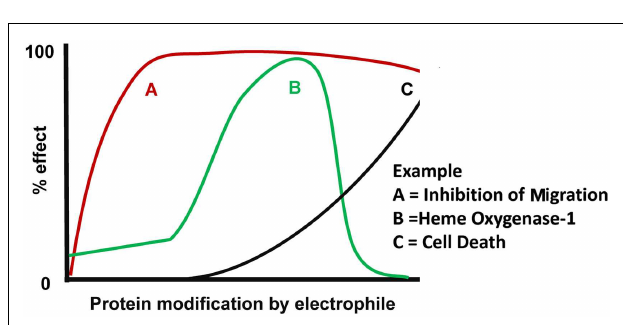
FIGURE 4 | Model of coordinated cellular effects in response to electrophilic protein modification. The overall cellular effects of an electrophile are dependent on the susceptibility of different target proteins to be modified by that electrophile.With low levels of electrophile exposure, post-translational modification of the most sensitive target will elicit a cellular response “A.”With moderate electrophile exposure, modification of (an) additional target(s) will result in cellular response “B.” Since response A is still present in this example, the combination of responses A and B cause a coordinated change in cell function by the same electrophilic mediator. With relatively high electrophile exposure, modification of a less sensitive target protein will elicit a new cellular response “C.” Since response A remains and response B is downregulated, the coordinated change in cell function is distinct from that observed at moderate electrophile